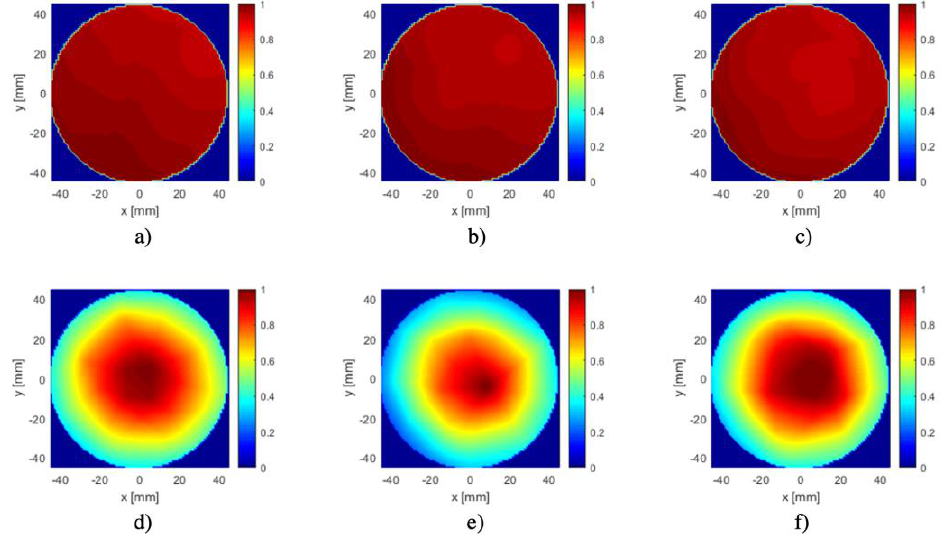
Figure 7 . Normalized transverse | 𝑩 𝟏+ | field maps of the four-ring DT-RF coil model on the central plane (z = 0). In ( a – c ) for the 7 T sodium Larmor frequency of the ‘long’, ‘short’ and ‘intermediate’ configuration, respectively. In ( d – f ) as for the first row but for the 7 T proton Larmor frequency.